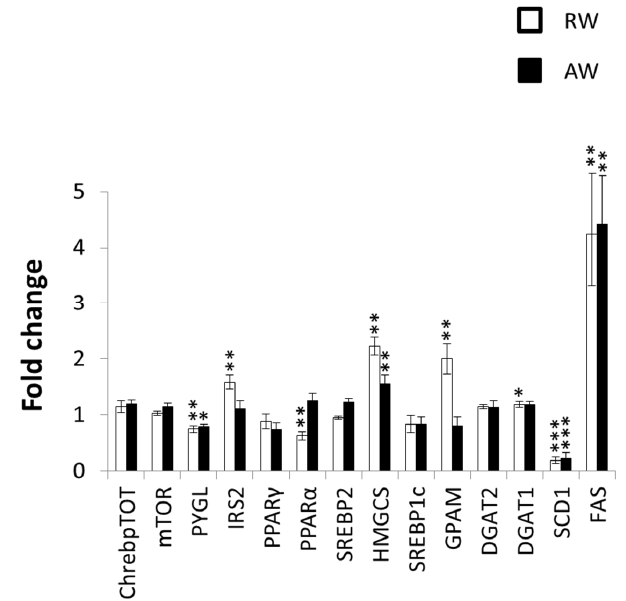
Figure 6. Expression levels of key metabolic genes in the liver from rest-workers (RW) and active workers (AW) following three work sessions, compared to undisturbed rats never exposed to simulated shift work. AW ( n = 10) were sacrificed at zeitgeber time (ZT)24, and RW ( n = 10) at ZT12. Undisturbed rats (RW control ( n = 5) and AW control ( n = 5) were sacrificed in a time-matched manner (i.e., at the same zeitgeber times as experimental animals). Fold changes for each gene represent the relative difference between shift work rats and controls. A fold change of 1 means no difference compared to controls, while a fold change of 2 means a doubling of transcriptional level, and a fold change of 0.5 a halving of the transcriptional level. * p < 0.05; ** p < 0.01; *** p < 0.001. ChrebpTOT, Carbohydrate-responsive element-binding protein; mTOR, Machanistic target of repemycin; PYGL, Phosphorylase, glycogen, liver; IRS2, Insulin receptor substrate 2; PPAR, Peroxisome proliferator-activated receptor; SREBP, Sterol regulatory element-binding protein; HMGCS, DGAT, Diacylglycerol O-acyltransferase; SCD1, Stearoyl-CoA desaturase 1; FAS, fatty acid